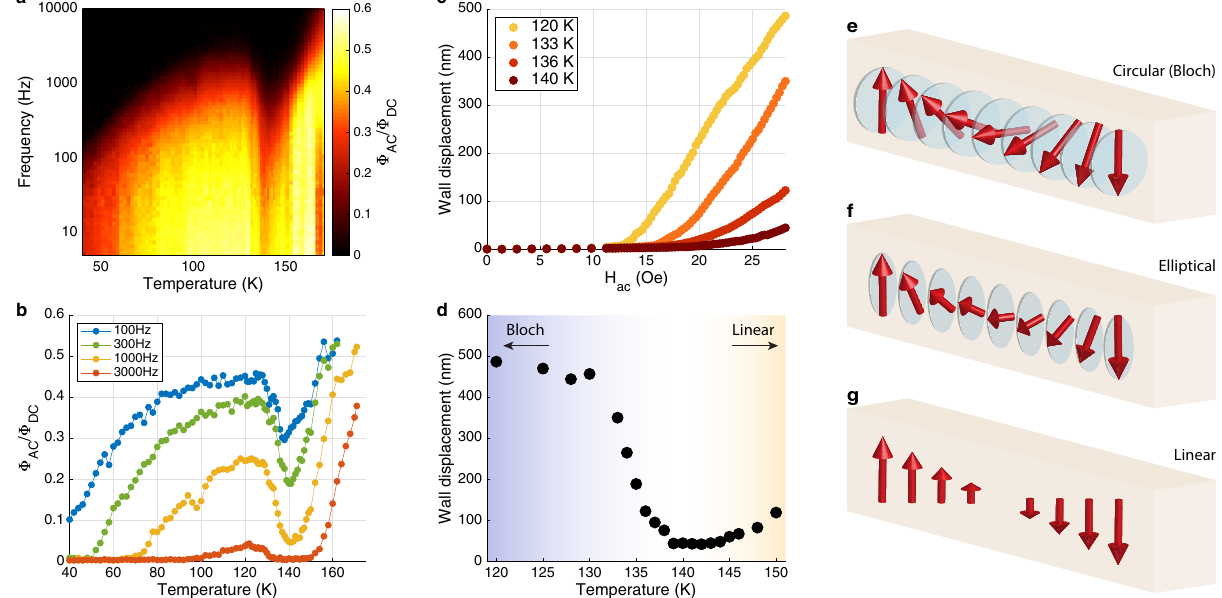
Fig. 2 DW displacement and linear wall phase transition. a Normalized ac Kerr response measured at a segment of a domain wall over a range of frequency (5 Hz – 10 kHz) and temperature (40 – 175 K). A sharp decrease in the Kerr response is noticeable near T = 140 K. b Selected plots of the temperature dependence at constant frequency (horizontal cuts through the frequency-temperature map shown in a ). c Measurements of the domain wall displacement plotted against ac magnetic fi eld amplitude at temperatures in the range of 120 – 140 K ( f ¼ 1 kHz, See Supplementary Fig. 4 for data at higher temperatures). d DW displacement versus temperature. The non-monotonic temperature dependence of the displacement can be understood as a phase transition from a e , circular or f , elliptical wall at low temperatures to a g , linear wall at high temperatures in which the magnetization vanishes at the wall